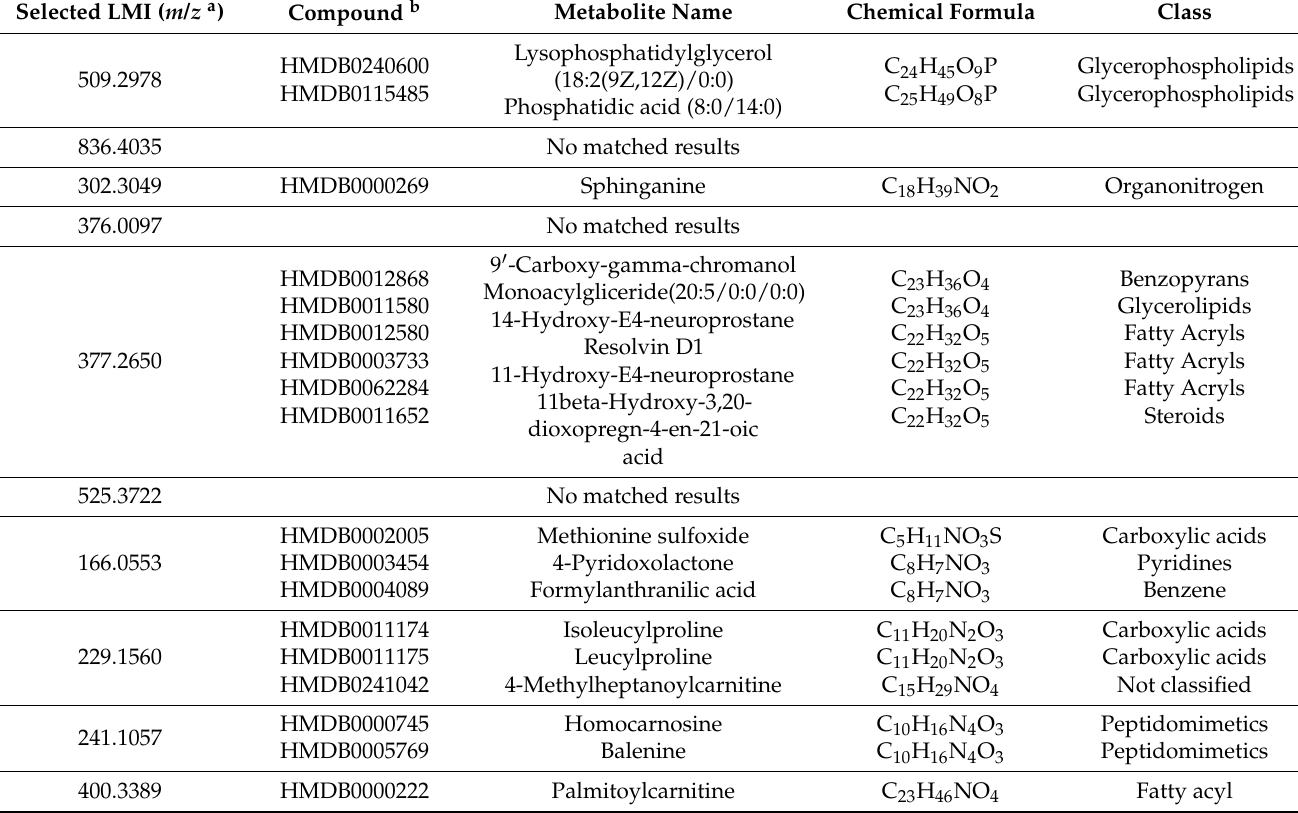
Table 5. Top 10 low mass ions in lumbar CSF, which were increased in spinal LM (+) than spinal LM ( −